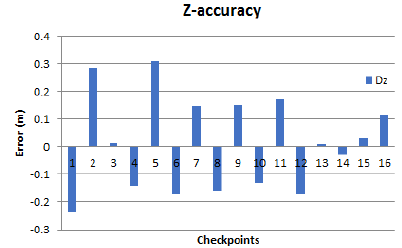
Figure 7: XY errors at checkpoints